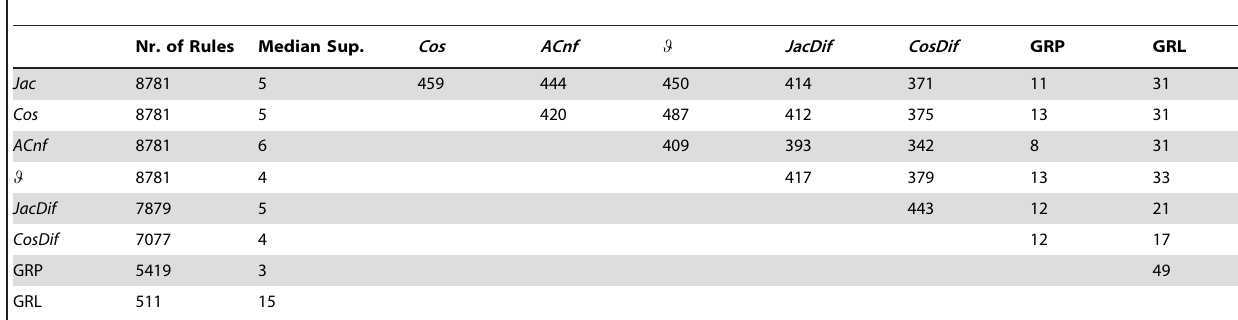
Table 8. Median absolute support and the number of intersections for GPCR-GO-MF dataset.